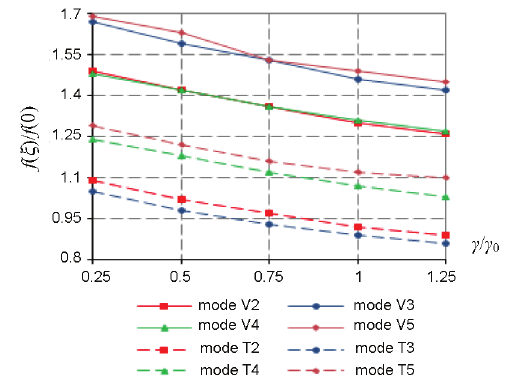
Fig. 11. The ratio between the frequency of the model with stiffened cables f ( ξ ) and that of the original system f (0) for all vertical and torsional modes versus the ratio γ/γ 0 of the mass density of the cable considering the stiffness parameter ξ = 2.0 of the cable